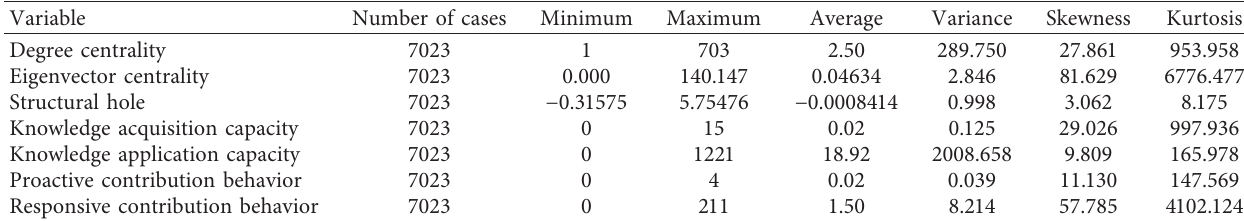
Table 3: Descriptive statistical